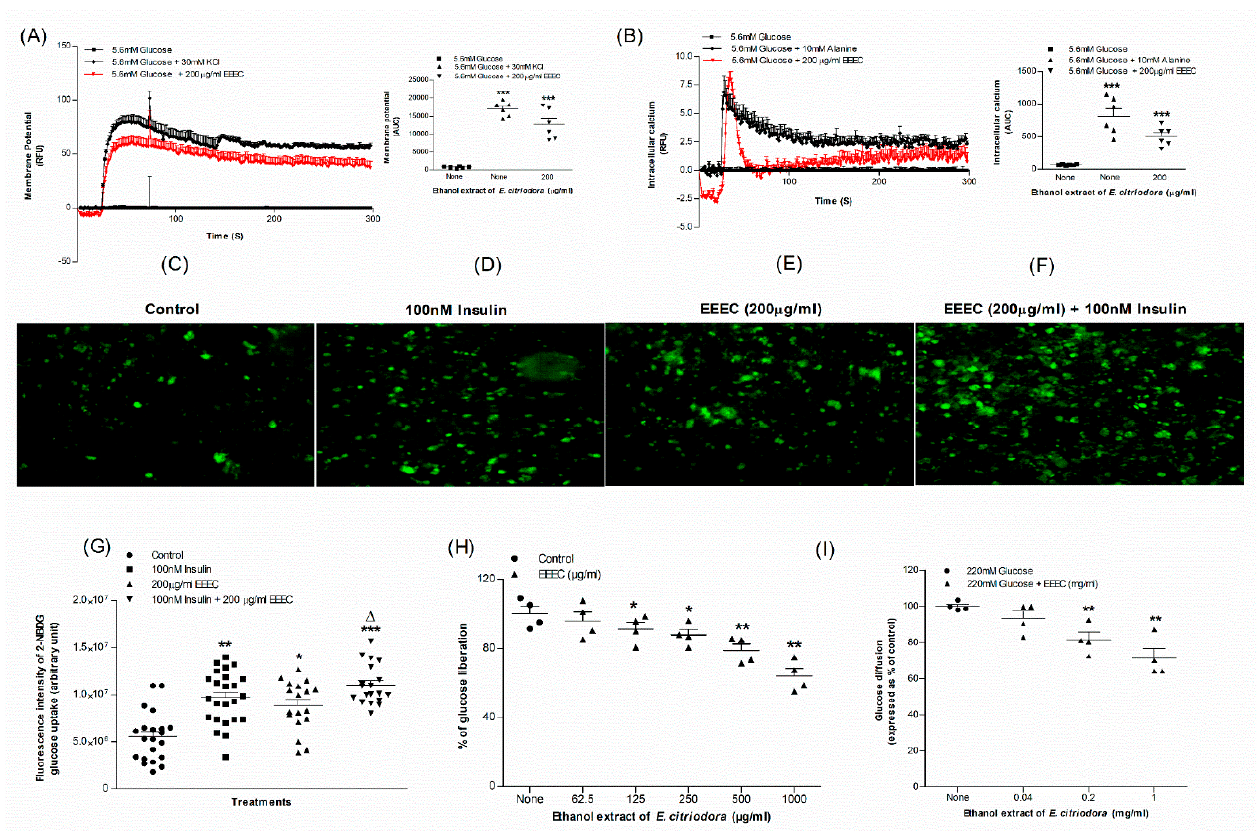
Figure 3. Effects of EEEC on ( A ) membrane potential and ( B ) intracellular calcium in clonal pancreatic β cell (BRIN BD11) and, ( C – G ) glucose uptake, ( H ) starch digestion and ( I ) glucose diffusion in vitro. Changes of fluorescence intensity in differentiated 3T3L1 adipocyte incubated with EEEC ( E ) minus or ( F ) plus 100 nM insulin. The × 10 magnification was used to take the images. Values n = 6 for membrane potential and intracellular calcium, n = 4 for uptake of glucose, digestion of starch and diffusion of glucose are mean ± SEM. * p < 0.05, ** p < 0.01, and *** p < 0.001 compared to control. ∆ p < 0.05 compared to insulin alone.